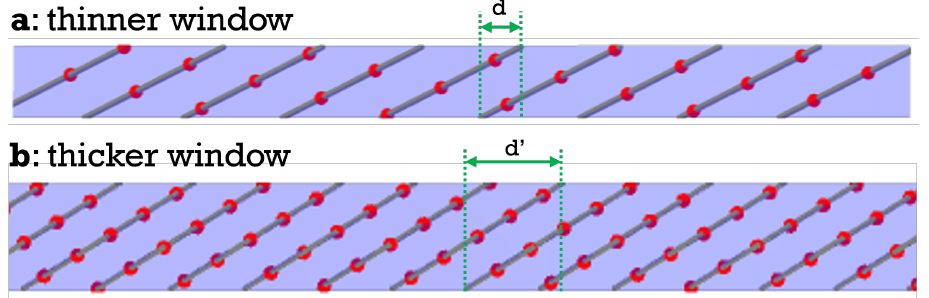
Figure 6. Comparing cut windows of different thickness: a. thinner window requires a smaller shear correction d to connect a section with its first neighbors and make a single helix; b. thicker window requires a larger shear correction d 0 for a single helix.